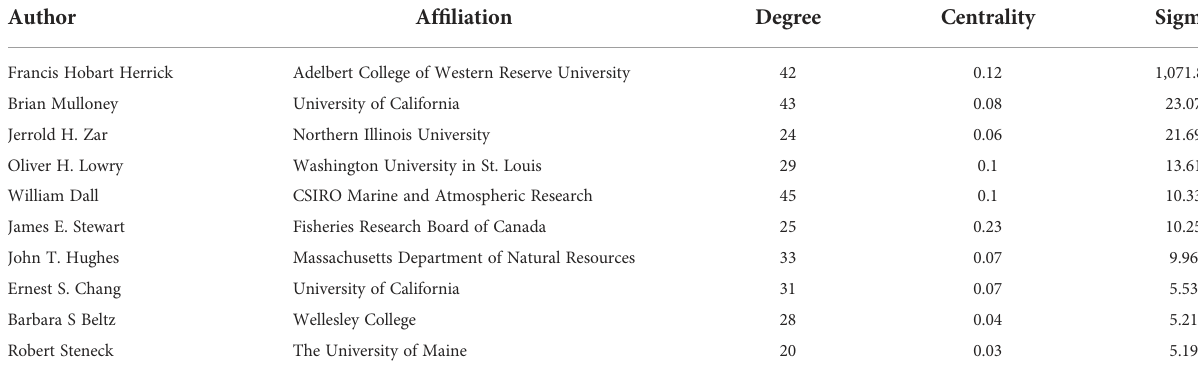
TABLE 1 Top 10 most in fl uential authors in marine lobster research, based on sigma score, organized in a descending